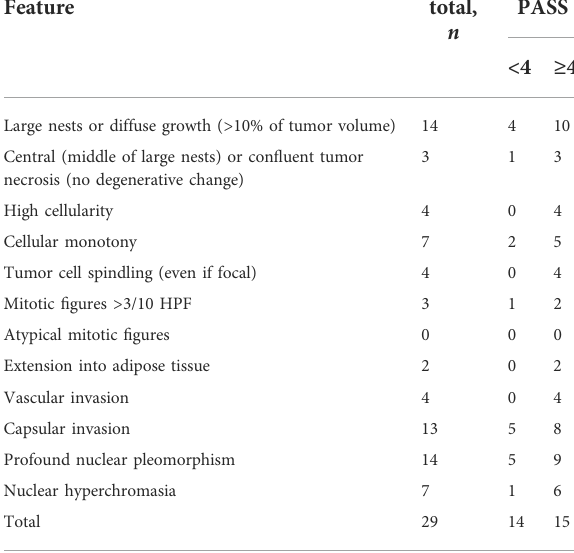
TABLE 2 Pathological characteristics of pheochromocytoma and paraganglioma in PASS score group.